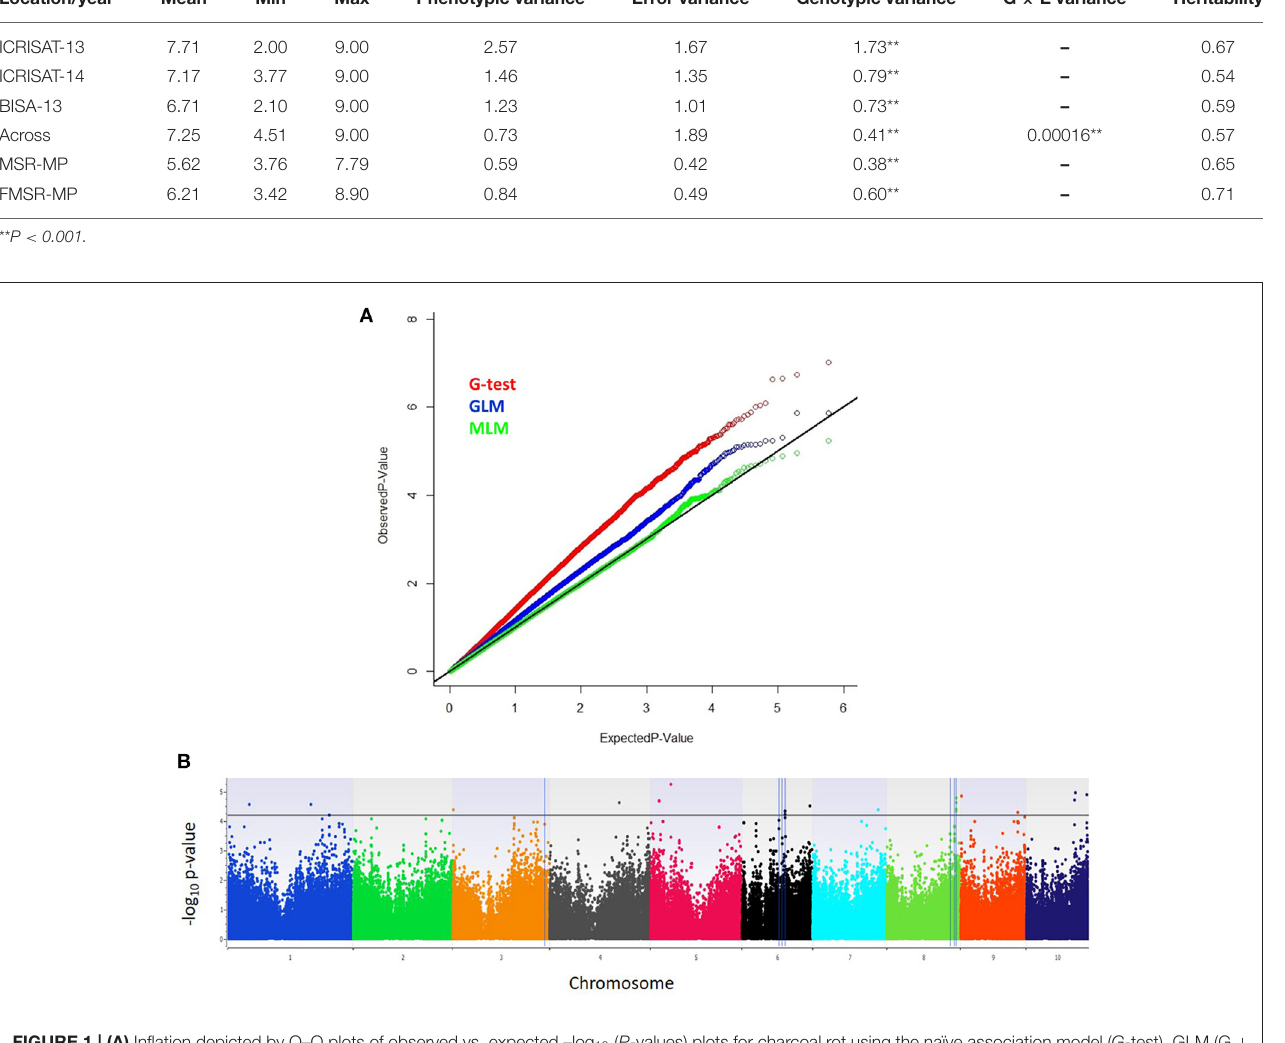
FIGURE 1 | (A) Inflation depicted by Q–Q plots of observed vs. expected –log 10 ( P -values) plots for charcoal rot using the naïve association model ( G -test), GLM (G + Q), and MLM (G + Q + K); G = genotype (fixed), Q = 10 principal components (fixed), K = kinship matrix (random) for CAAM panel. (B) Highly significant SNPs identified from MLM model using Manhattan plot, plotted with the individual SNPs on the X -axis and –log 10 P -value of each SNP on the Y -axis. The horizontal line showed the cutoff P -value, and the vertical line represents the identified QTLs and haplotype blocks in these regions for charcoal